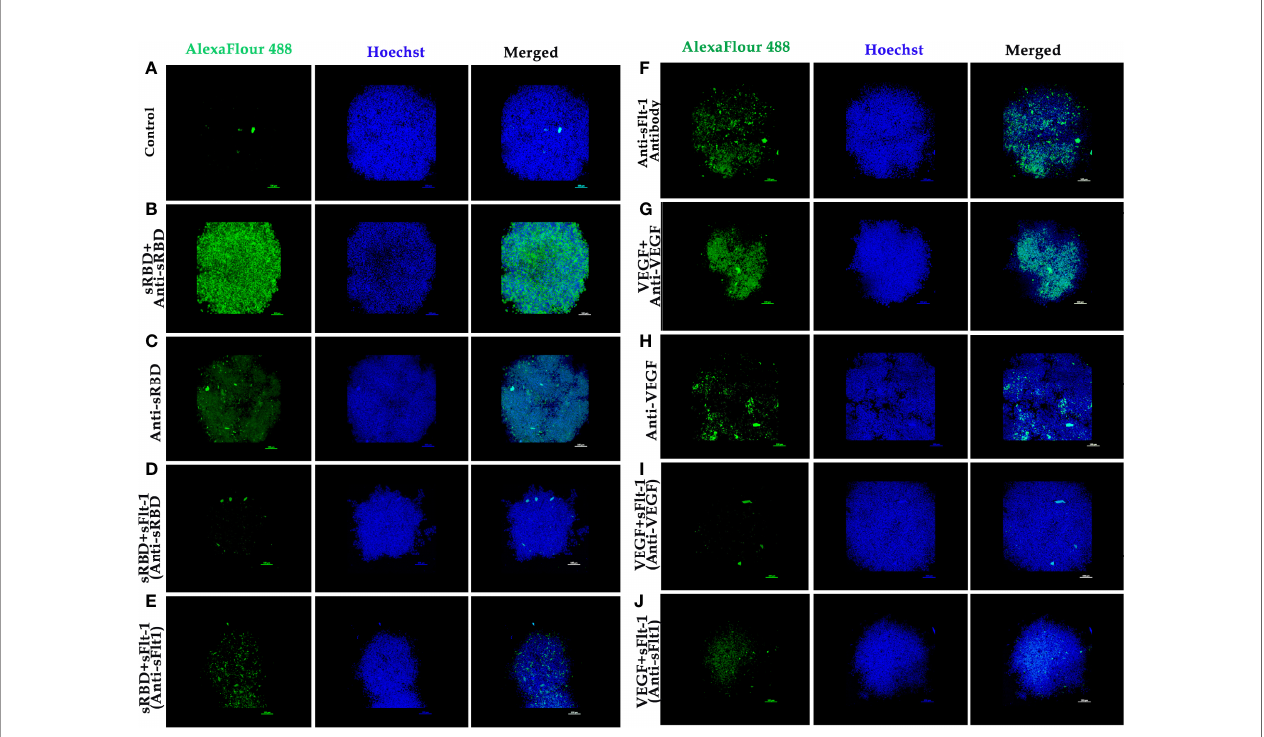
FIGURE 8 | Immuno fl uorescence of 3D spheroids of MDA-MB 231 cells to demonstrate binding of rspike RBD or rVEGF to Flt-1 receptors: (A) 3D spheroid (control). (B) Spheroids were treated with rspike RBD and probed with anti-Spike RBD antibody followed by goat anti-rabbit AlexaFlour 488 secondary antibody showing strong fl uorescence signal (green fl uorescence) which indicates binding of spike RBD to cellular receptors, Hoechst was used for nuclei staining (blue fl uorescence). (C) Spheroids probed with anti-Spike RBD antibody. (D, E) Spheroid was treated with pre-incubated rspike RBD and rsFlt-1 mixture and probed either with anti-Spike RBD or anti-Flt1 antibody (no fl uorescence signals were reported revealing spike RBD and sFlt-1 interaction in the incubation period prior to adding the complex to the spheroids. (F) Spheroid probed with anti-sFlt-1 antibody shows fl uorescence signals due to binding of sFlt-1 antibody to Flt-1 receptors on the cells. (G) Spheroid was treated with rVEGF and probed with an anti-VEGF antibody shows fl uorescence signals due to binding of VEGF antibody to VEGF on the cells. (H) Spheroid probed with anti-VEGF antibody. (I, J) Spheroid was treated with pre-incubated rVEGF and rsFlt-1 mixture and probed either with anti-VEGF or anti-Flt-1 antibody leads to loss of fl uorescence signals which may be as a result of interaction between VEGF and sFlt-1 during incubation period prior to adding the mixture into the spheroids. The scale bar indicates 10X magni fi